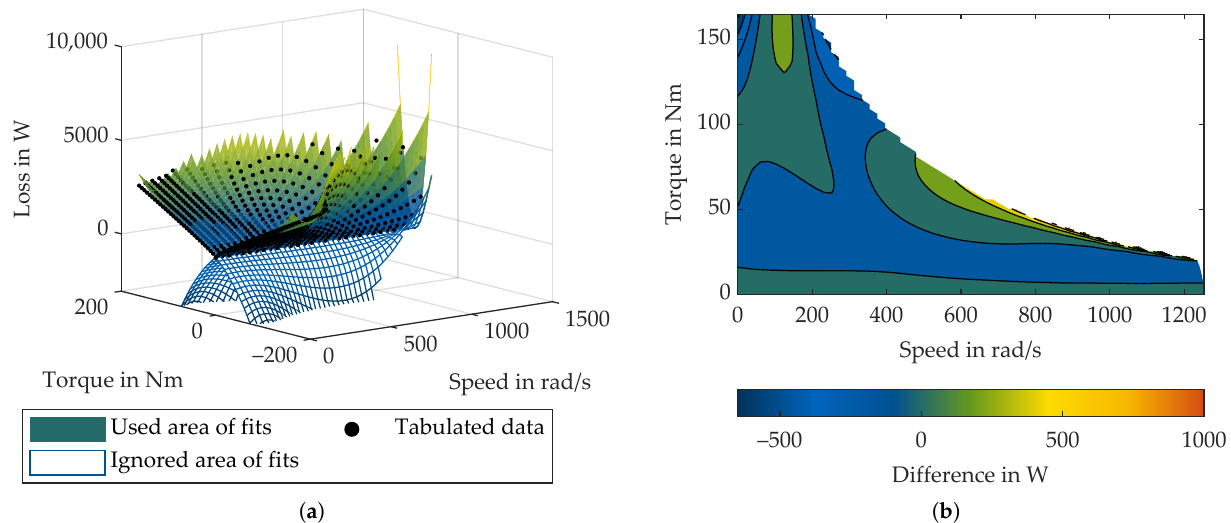
Figure A4. ( a ) Electrical motor losses of the IM: fits of the split meta-model and the corresponding data points of the tabulated model. The ranges used due to the inequality constraints of Equations (36) and (37) are highlighted with surface color. Irrelevant ranges of the fits are presented with grid lines only. ( b ) Difference between fit and tabulated electrical motor